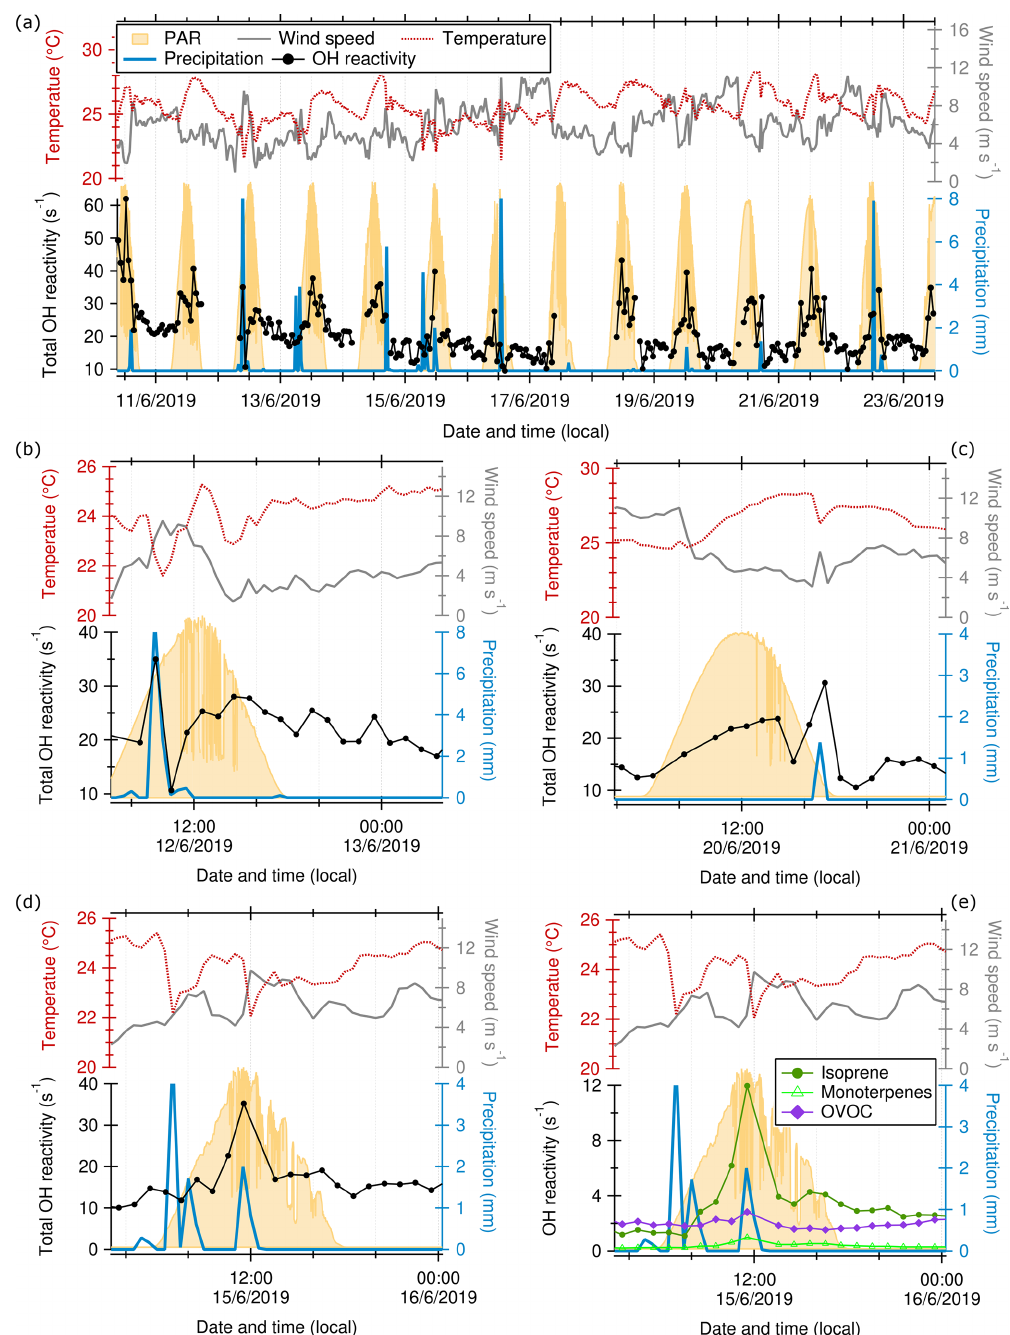
Figure 9. Total OH reactivity (measured at 80ma.g.l., hourly averages), wind speed, temperature, and precipitation (measured at 320m, 30min averages) time series in June 2019 at the ATTO tall tower. PAR is photosynthetically active radiation, measured at the nearby walk-up tower. (a) Complete time series; (b) , (c) , and (d) zoomed-in example rain events; (e) zoomed-in rain event as in (d) but with OH reactivity calculated from isoprene, monoterpenes, and